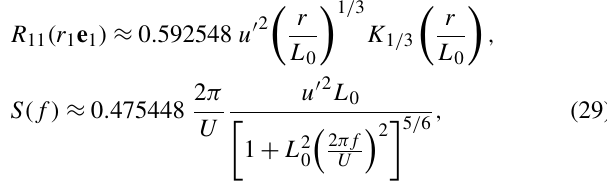
Figure 5. Scaling of N 2 measured signal (POST). The linear fit from Eq. (21) is given by the magenta dashed